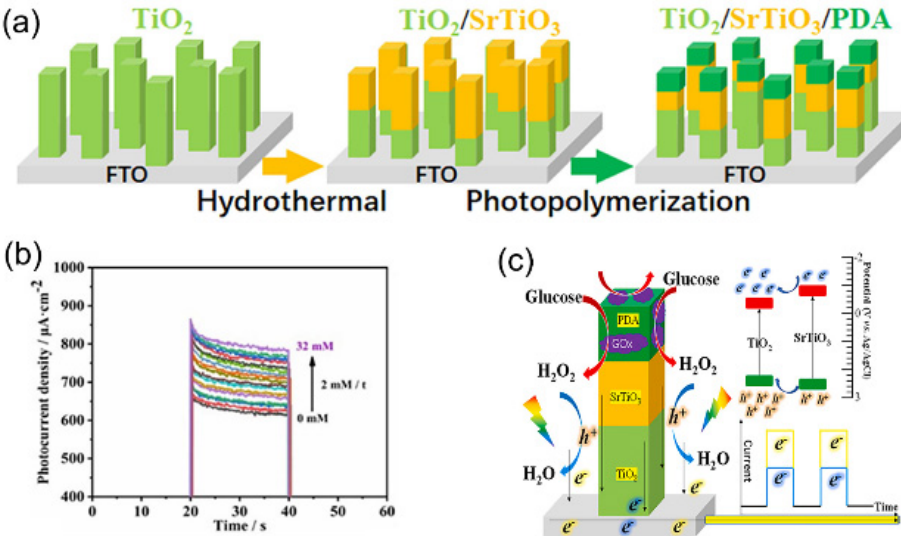
Figure 4. ( a ) Guidelines for the design of TiO 2 /SrTiO 3 /PDA electrodes. ( b ) TiO 2 /SrTiO 3 /PDA/GO x in 0.1 M PBS (pH7.4) electrolyte to glucose concentration from 0–32 mM increasing photocurrent time density reaction. ( c ) Heterojunction mechanism of TiO 2 /SrTiO 3 and reaction mechanism of TiO 2 /SrTiO 3 /PDA/GO x . Reproduced with permission from Ref. [36]; published by Elsevier Ltd., 2021.